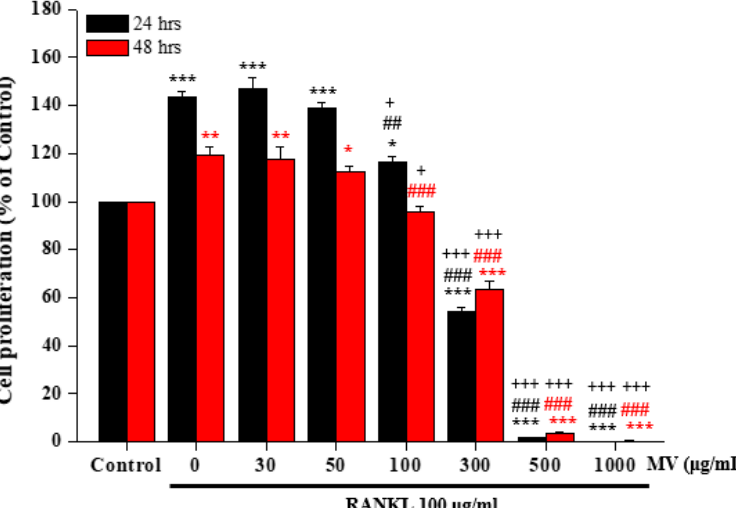
vinegar in the femur of ovariectomized rats.